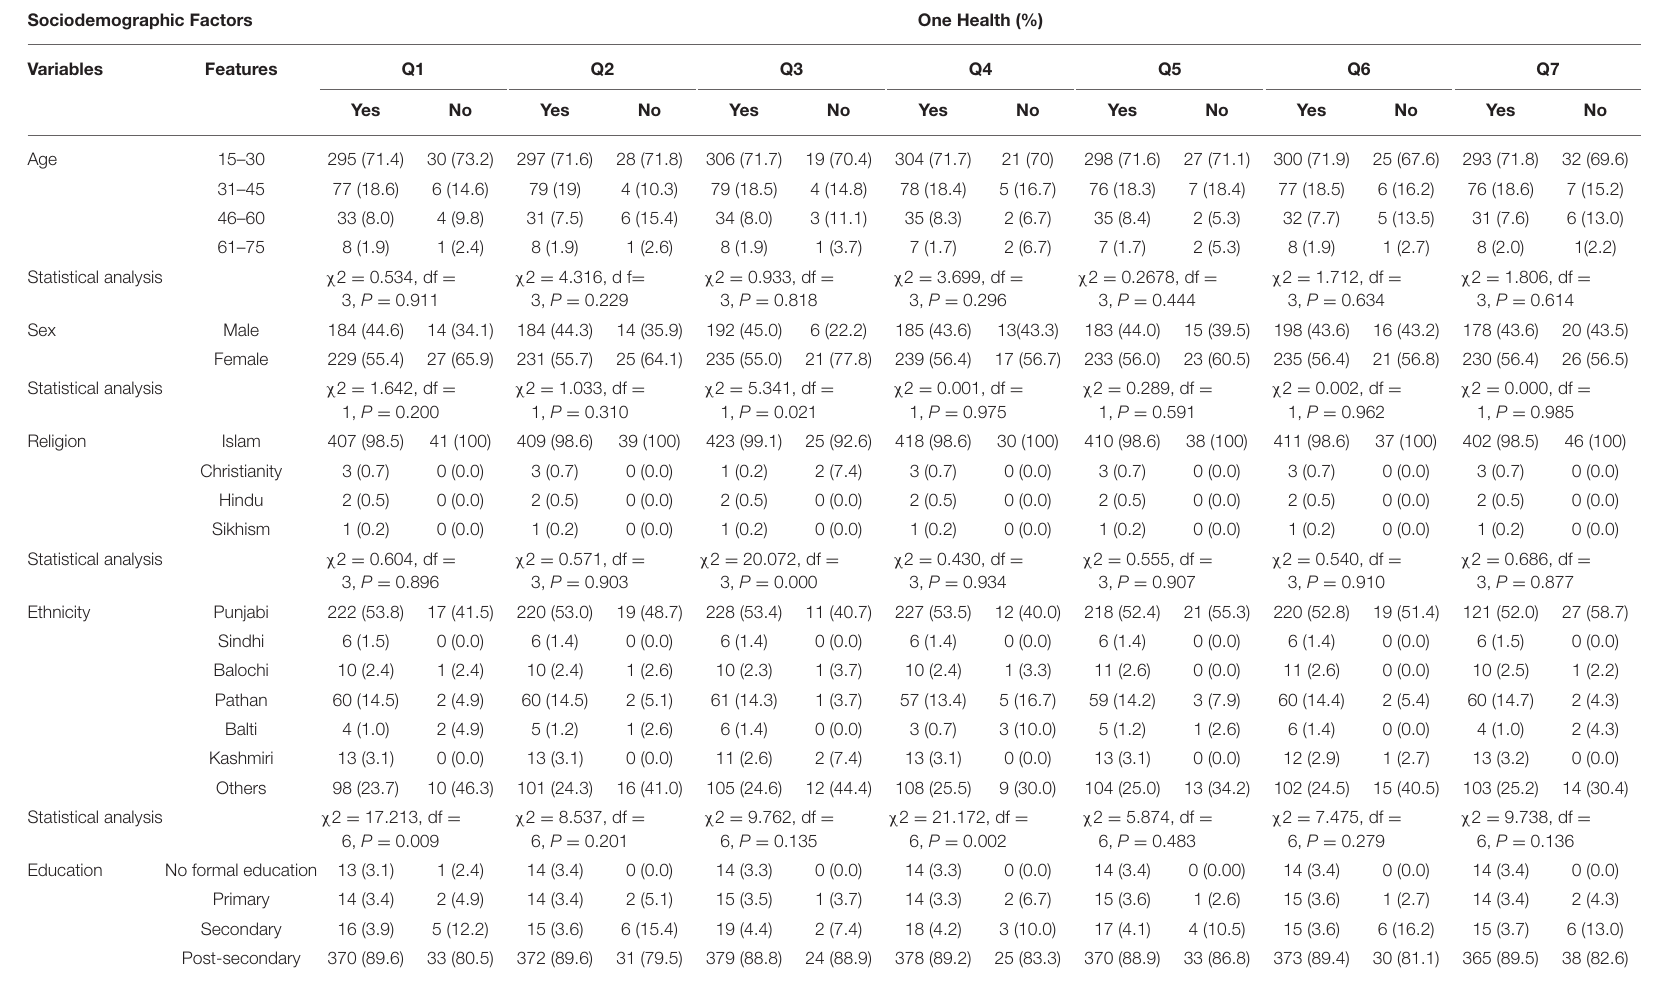
TABLE 6 | Representation of Sociodemographic factors across One Health concept of CE